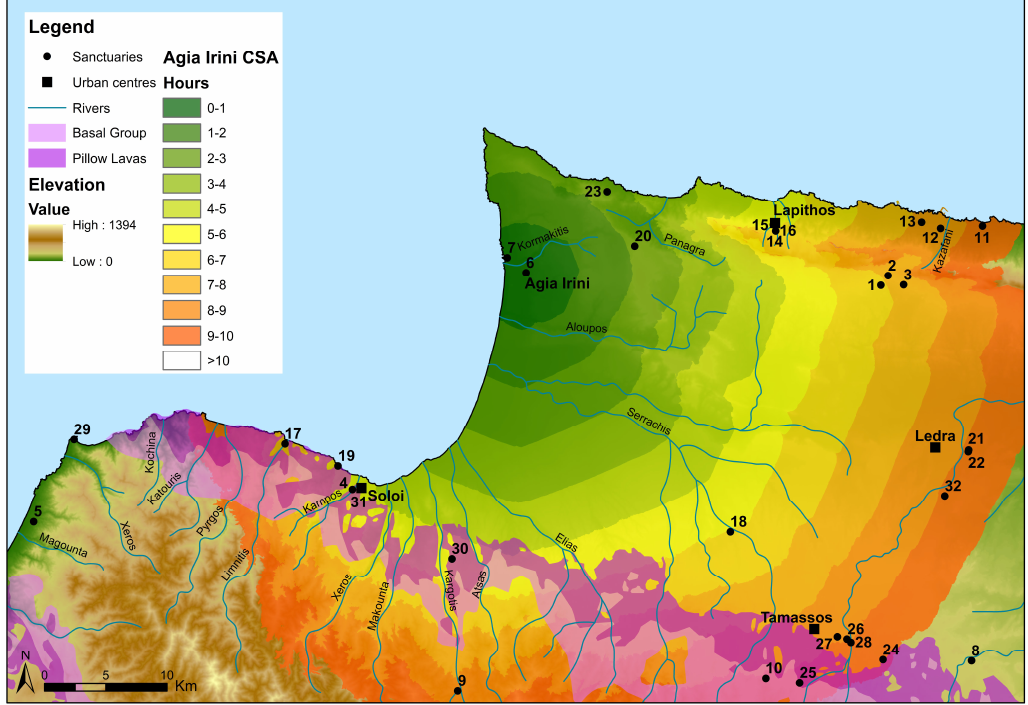
Figure 11. Cost Surface Analysis from Agia Irini; Digital data courtesy of the Geological Survey Department, Cyprus (by Dr Charalambos